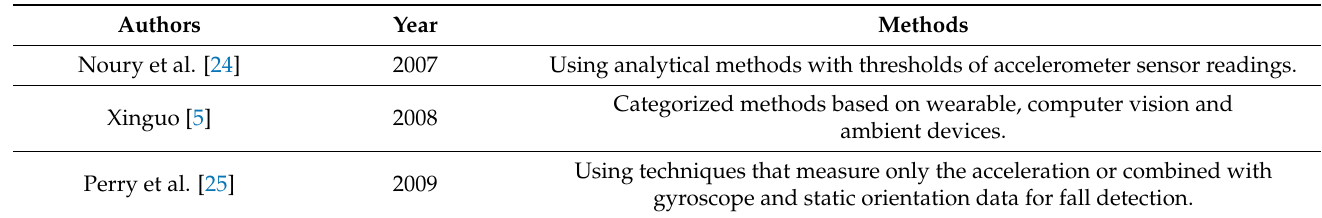
Table 1. Taxonomy of main fall detection methods with different sensing